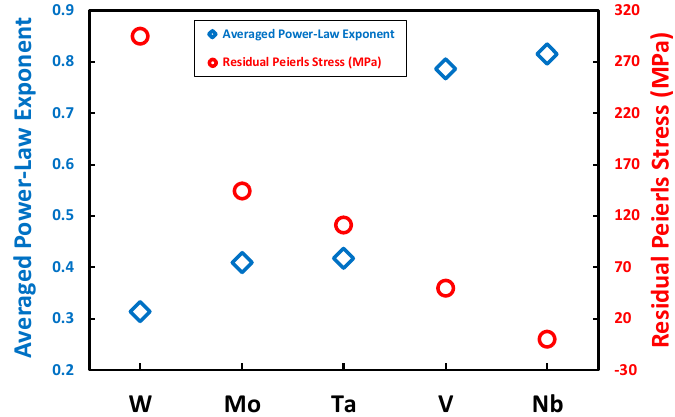
Figure 5. Comparison of power law exponents versus residual Peierls barrier at room temperature in BCC metals (after Greer and De Hosson [3]).